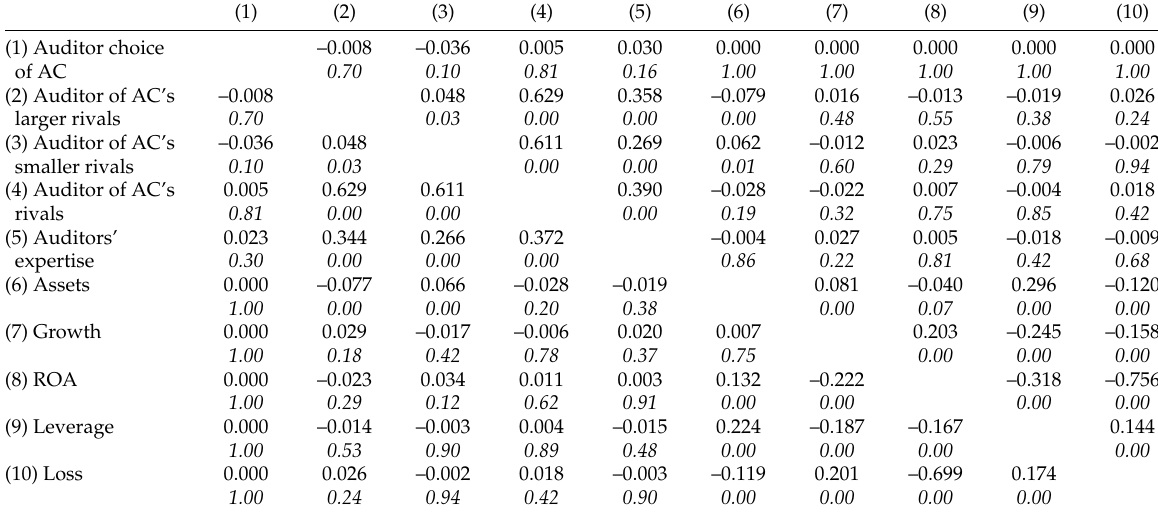
Table 2 reports the summary statistics and correlations between variables. Def- initions of all variables are presented in Appendix A of the online